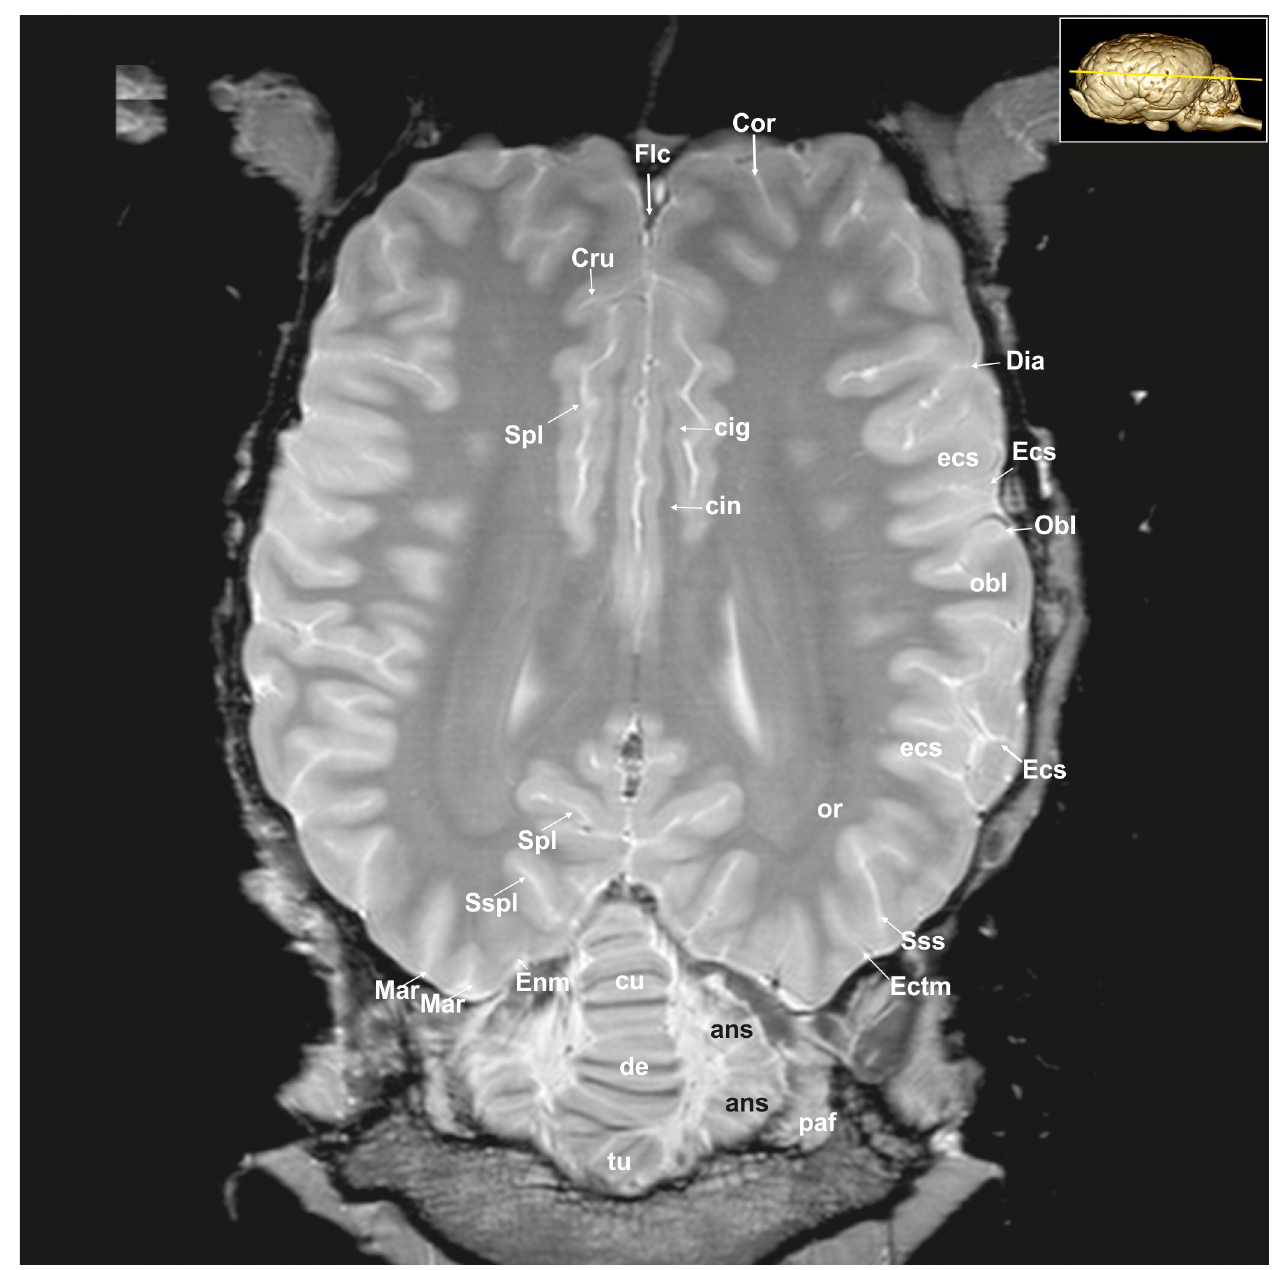
Fig 24. Dorsal magnetic resonance image of the equine brain on the level of the cingulated gyrus. ans: ansiform lobule, ci: cingulum, Cor: coronal sulcus, Cru: cruciate sulcus, cu: culmen, de: declive of the vermis, Dia: diagonal sulcus, Ecs: ectosylvian sulcus, ecs: ectosylvian gyrus, Ectm: ectomarginal sulcus, Enm: endomarginal sulcus, Flc: longitudinal cerebral fissure, Mar: marginal sulcus, Obl: oblique sulcus, obl: oblique gyrus, or: optic radiation, paf: paraflocculus, Spl: splenial sulcus, Sspl: suprasplenial sulcus, Sss: suprasylvian sulcus, tu: tuber of the